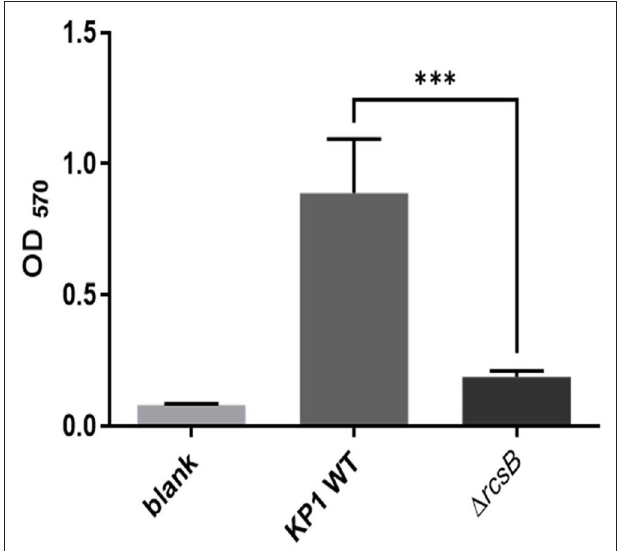
FIGURE 1 | Biofilm formation of Klebsiella pneumonia KP1, 1 rcsB , and sterile LB broth as blank. The *** denotes P <